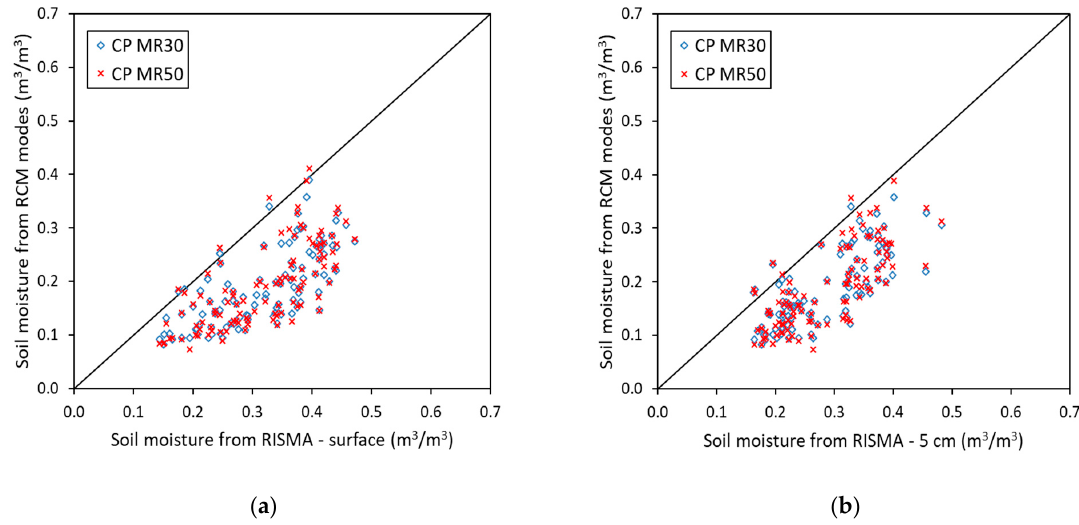
Figure 7. Comparison between retrieved soil moisture values from RCM CP modes and RISMA in-situ measurements at surface ( a ) and at 5 cm soil depth ( b ). Table 4. Estimation error statistics between RCM CP soil moisture retrievals and RISMA in-situ measurements.